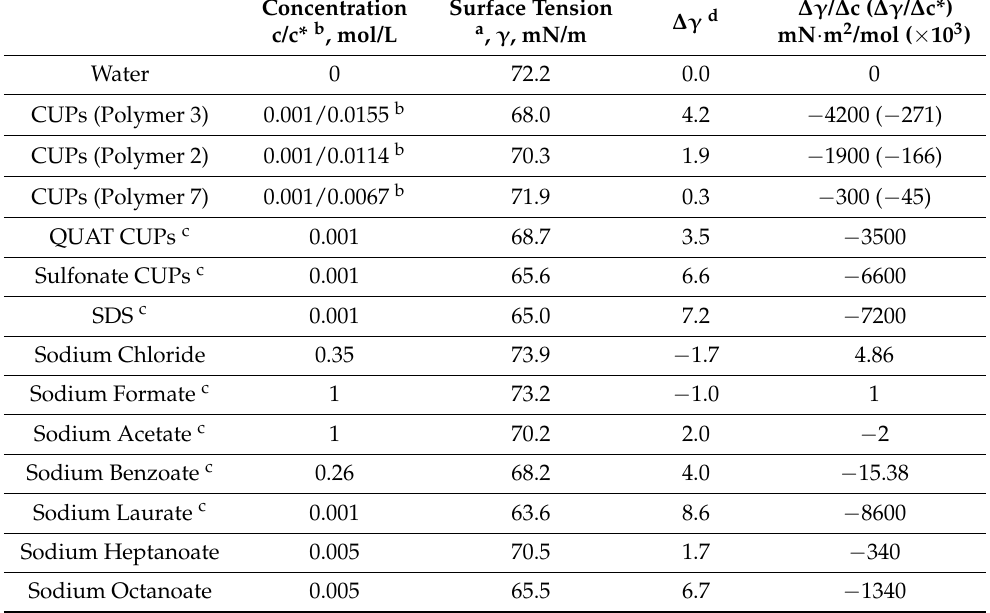
Figure 2. Equilibrium surface tension (mN/m) vs. the molar concentration (mol/m 3 ) of CUP solution made from polymers 1–8. Table 4. Comparison of the surface tension of CUPs surfactants, sodium chloride and sodium carboxylates.